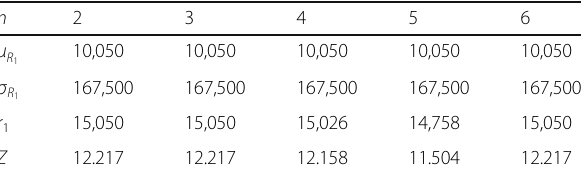
Table 2 Statistical